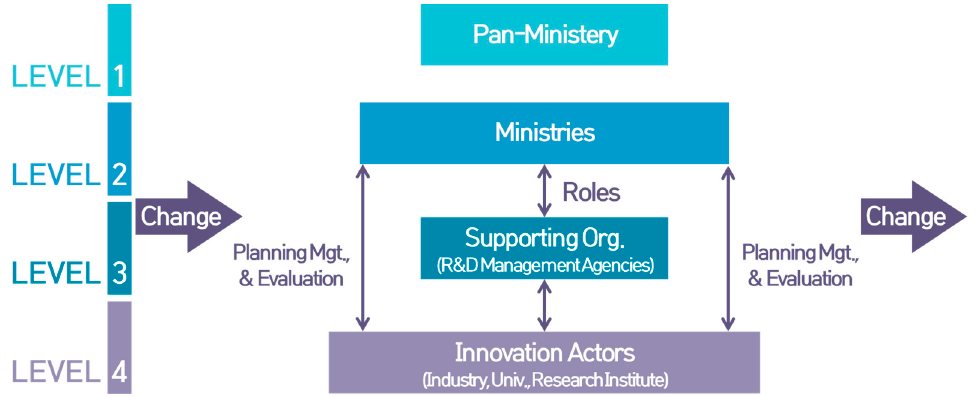
Figure 1. Mechanism of the national R and D program management in the National Innovation System. Source: Impact of Organizational Competencies on the Performance of R and D Management Agencies in Korea [2].